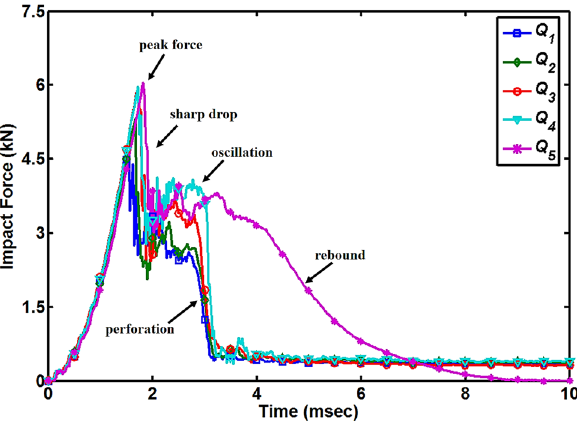
Figure 3. Impact force versus time diagram for all quasi-isotropic composite plates.